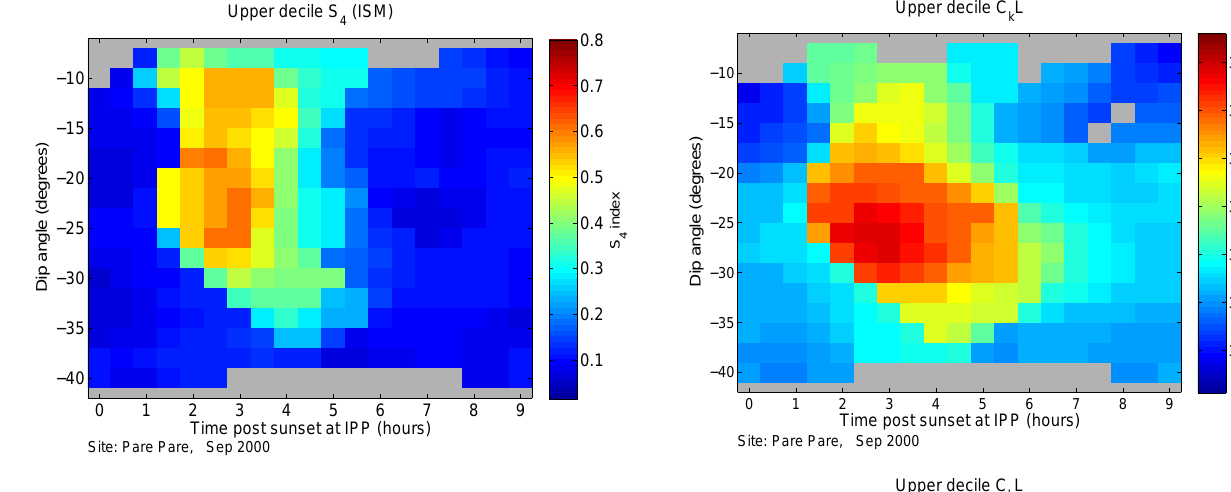
Fig. 3. Upper decile slant S 4 index at Pare Pare during September 2000.